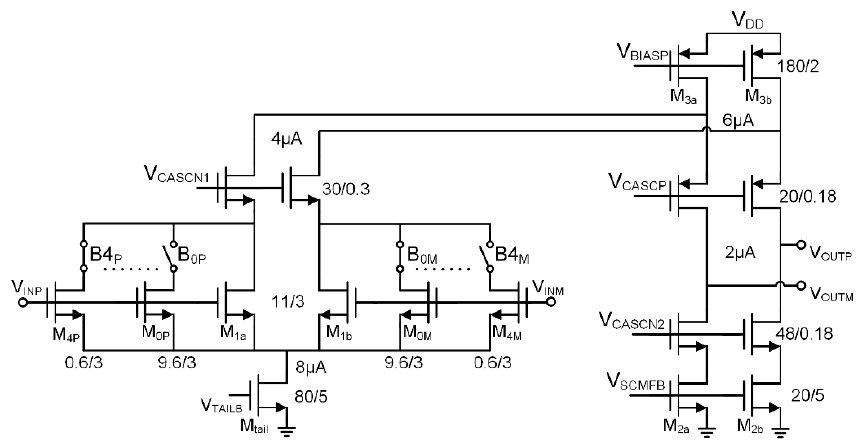
Figure 9. Transistor level design of the transconductance amplifier used in the windowed integration sampler (G M in Figure 6). A folded cascode architecture was selected for high output resistance and moderate output swing. A 5-bit fine offset correction digital-to-analog converter was implemented through an array of differential pair devices.